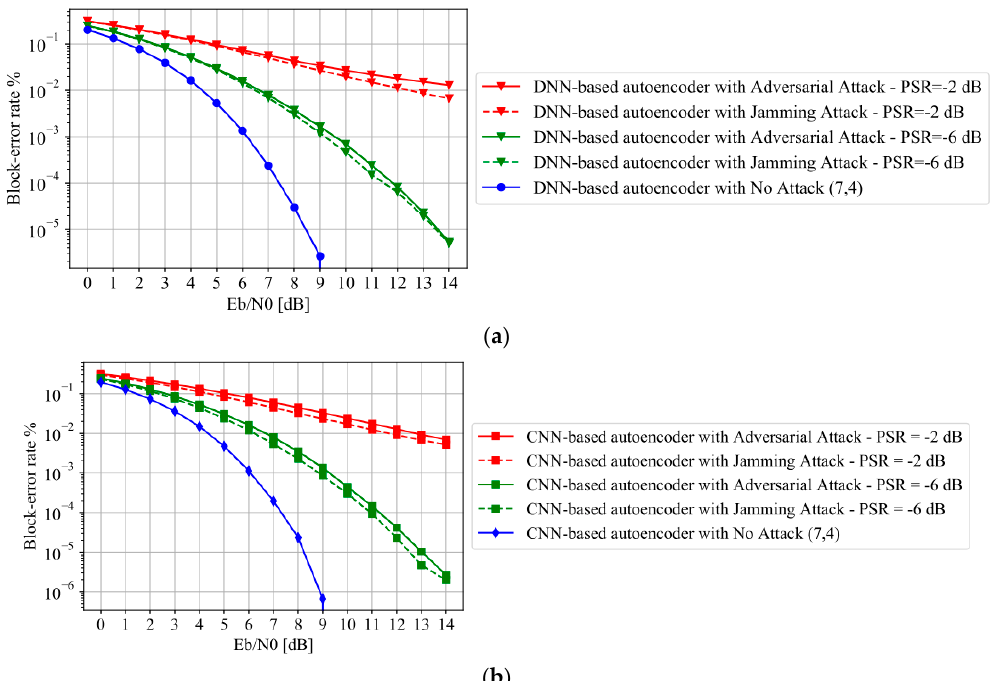
Figure 4. Block-error-rate (BLER) versus E b / N 0 under randomly shifted adversarial attacks and jamming attacks. ( a ) autoencoder based on deep neural networks (DNN); ( b ) autoencoder based on convolutional neural network